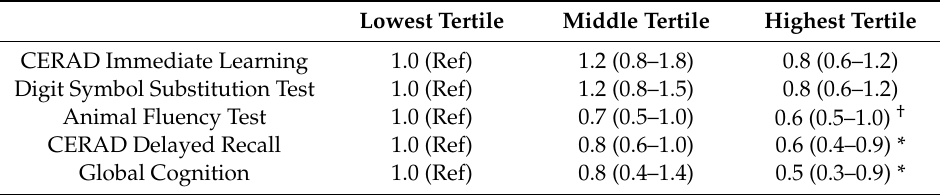
Table 6. Sensitivity analysis of survey-weighted odds ratios (95% confidence intervals) for low cognitive performance across tertiles of MedD adherence within National Health and Nutrition Examination Survey (NHANES) participants with no subjective memory complaints ( n = 2579). Lowest Tertile Middle